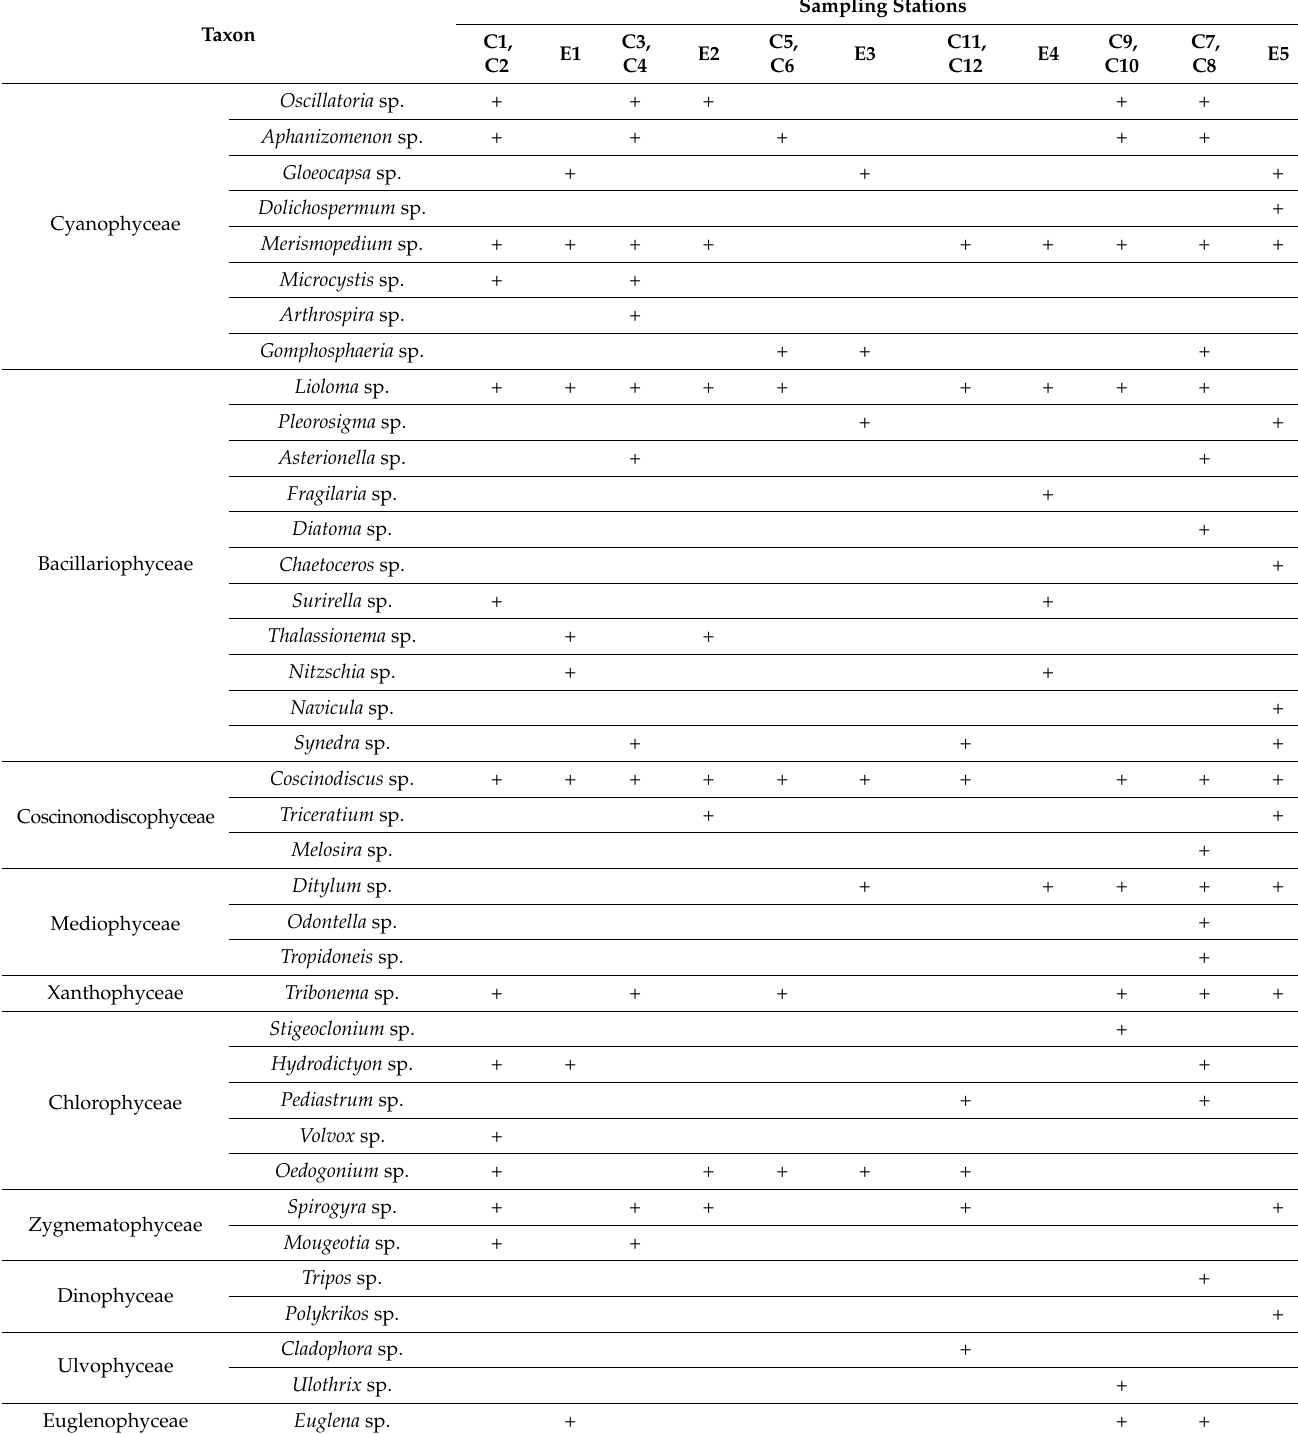
Table 4. Presence (+) or absence (blank) of phytoplankton species in the tidal mangrove creeks and the